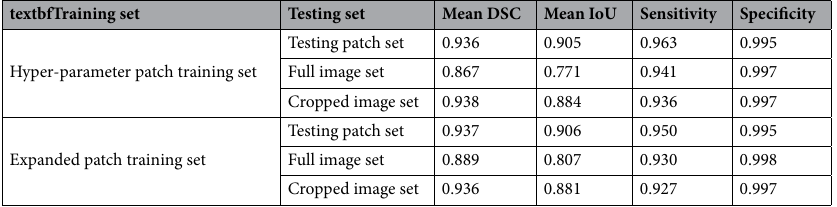
Table 5. Results for each of the models on different testing sets.